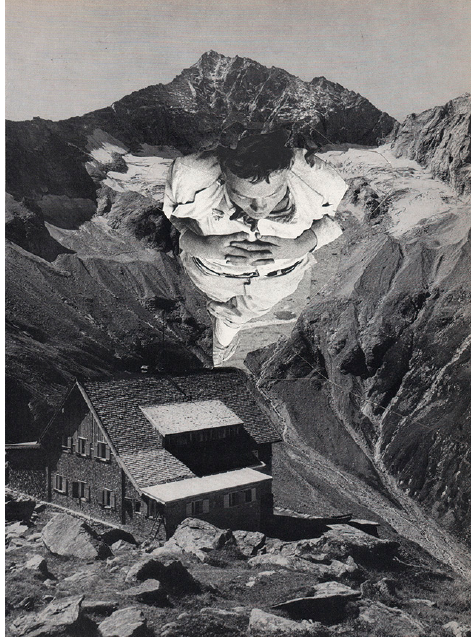
Figure 5. Sabine Hertig, Untitled 2010, Analogue Collage on Paper. 24.5 × 18 cm, Archive No.